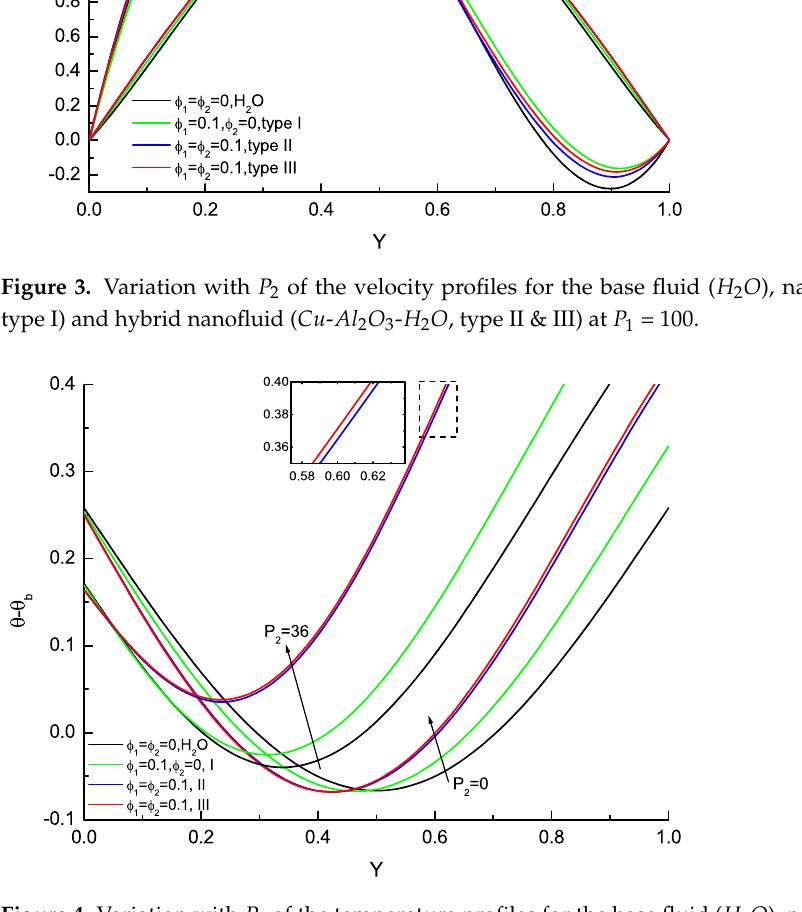
Figure 4. Variation with P 2 of the temperature profiles for the base fluid ( H 2 O ), nanofluid ( Cu - H 2 O , type I) and hybrid nanofluid ( Cu - Al 2 O 3 - H 2 O , type II & III) at P 1 =